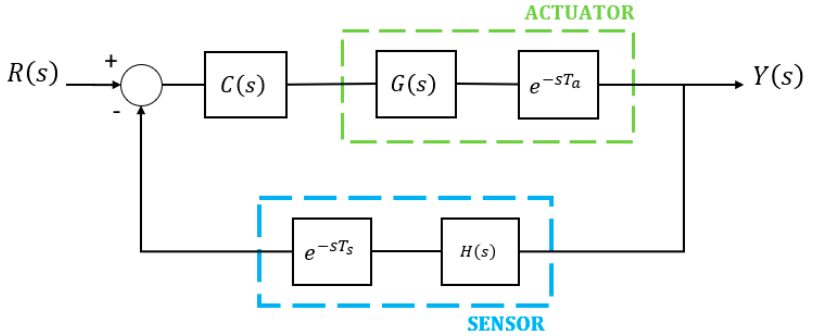
Figure 11. Basic closed-loop system with sensor and actuator delays.